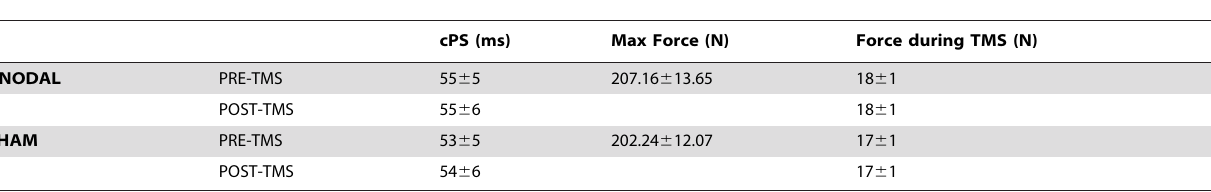
Table 3. Cortical silent period and wrist extension force.